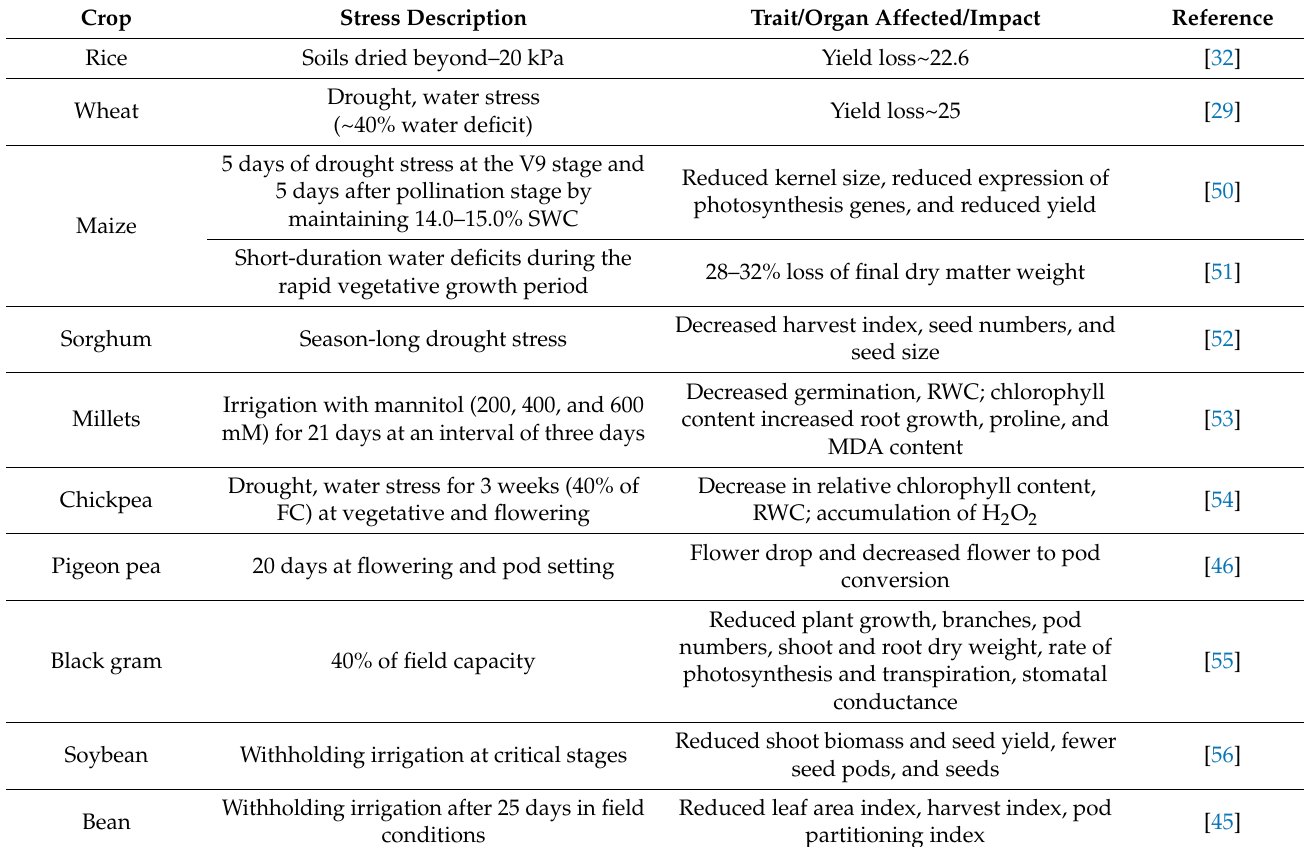
Table 2. Physiological and biochemical responses of plants under drought